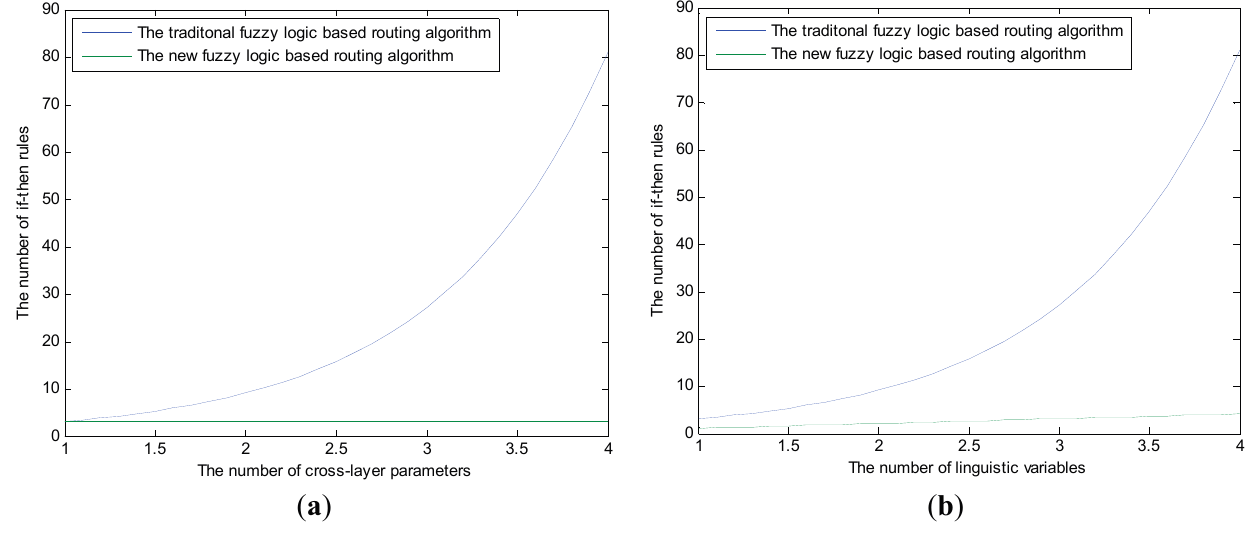
Figure 6. ( a ) The relationship of the number of if-then rules and the number of cross-layer parameters; ( b ) The relationship of the number of if-then rules and the number of the linguistic